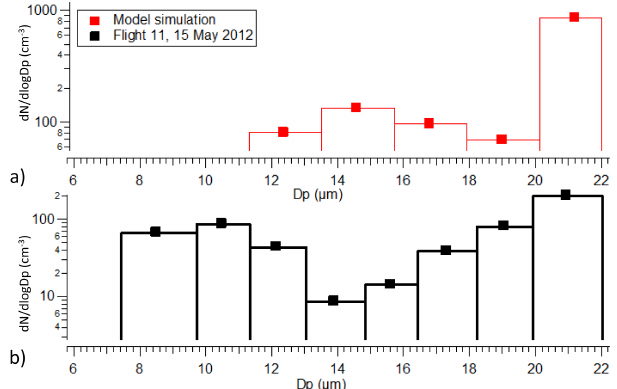
Figure 13. (a) A bimodal size distribution of the cloud droplets as obtained from the direct numerical simulation for the last 70m of the simulated aircraft trajectory. (b) For comparisons the measured bimodal size distribution from Flight 11 as also shown in Fig.